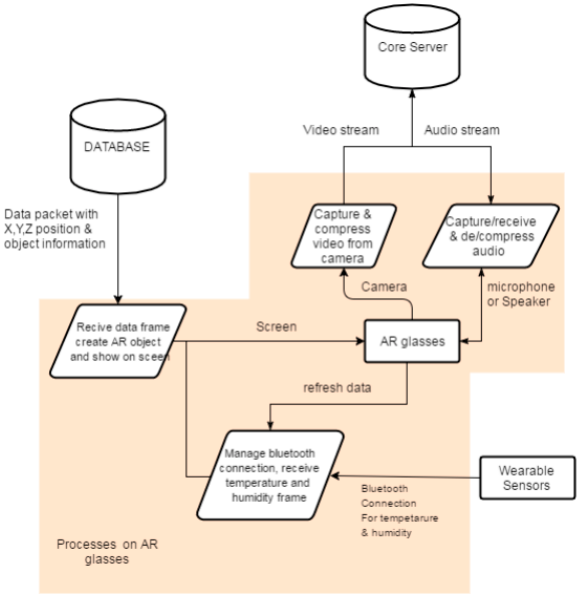
Figure 6. Data flow between servers, smart glasses and wearable